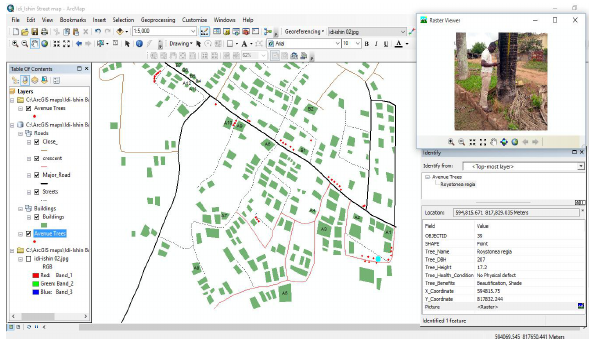
Figure 4. Query for Avenue trees (Polyanthia longiflora) available in the study area